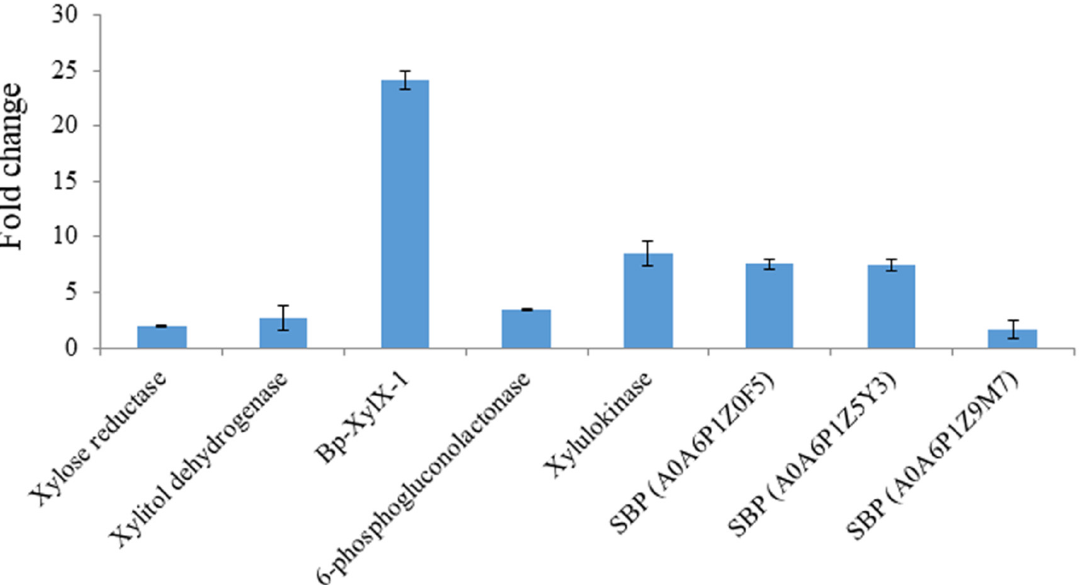
Figure 7. Proteomics analysis of B. producta ATCC 27340 grown on 1% XOS. Bacterium was grown on 1% XOS containing minimal medium, and proteomics analysis was performed on total intracellular proteins. Protein FASTA files for B. producta from UniProtKB (UP000464715; 5365 protein entries) was used for protein identification. SBP: solute-binding proteins of the ATP-binding cassette transporters (ABC transporters).